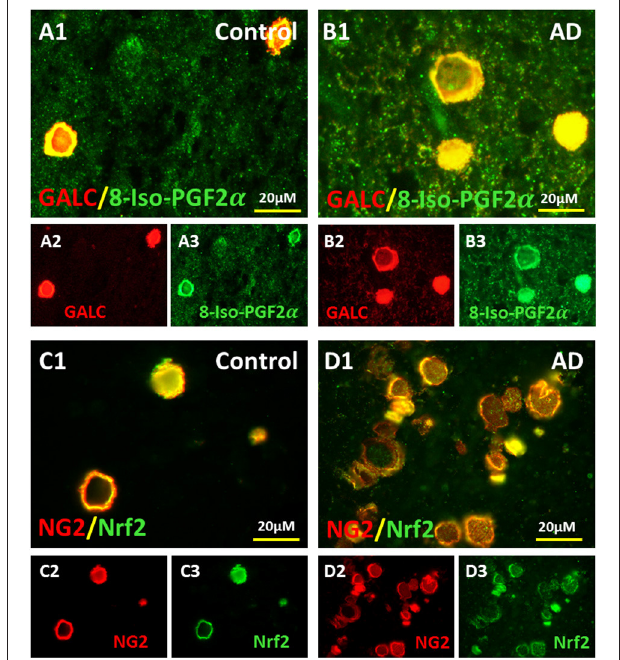
FIGURE 3 | Colocalization of OLs and OPCs markers with oxidative markers in the vesicles of AD and aging brains. Oligodendrocyte marker, GALC, in control (A2) and AD brains (B2) and 8-Iso-PGF2 α in control (A3) and AD brains (B3) colocalized in control (A1) and AD brains (B1) . Oligodendrocyte precursor cell (OPCs) marker, NG2, in control (C2) and AD brains (D2) and oxidative stress marker Nrf2 in control (C3) and AD brains (D) colocalized in control (C1) and AD brains (D1) . Note: OL, oligodendrocyte; OPC, oligodendrocyte precursor cell; GALC, Galactocerebroside; NG2, neuron-glial antigen 2; Nrf2, Nuclear factor erythroid 2-related factor 2; AD, Alzheimer’s disease; Bar = 20 µ